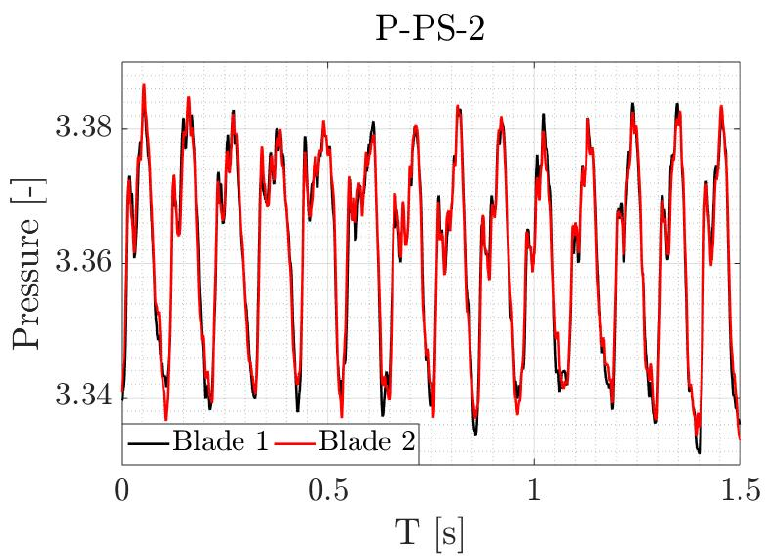
Figure 8. Numerical absolute pressure was recorded at P-PS-2 on two opposite runner blades.